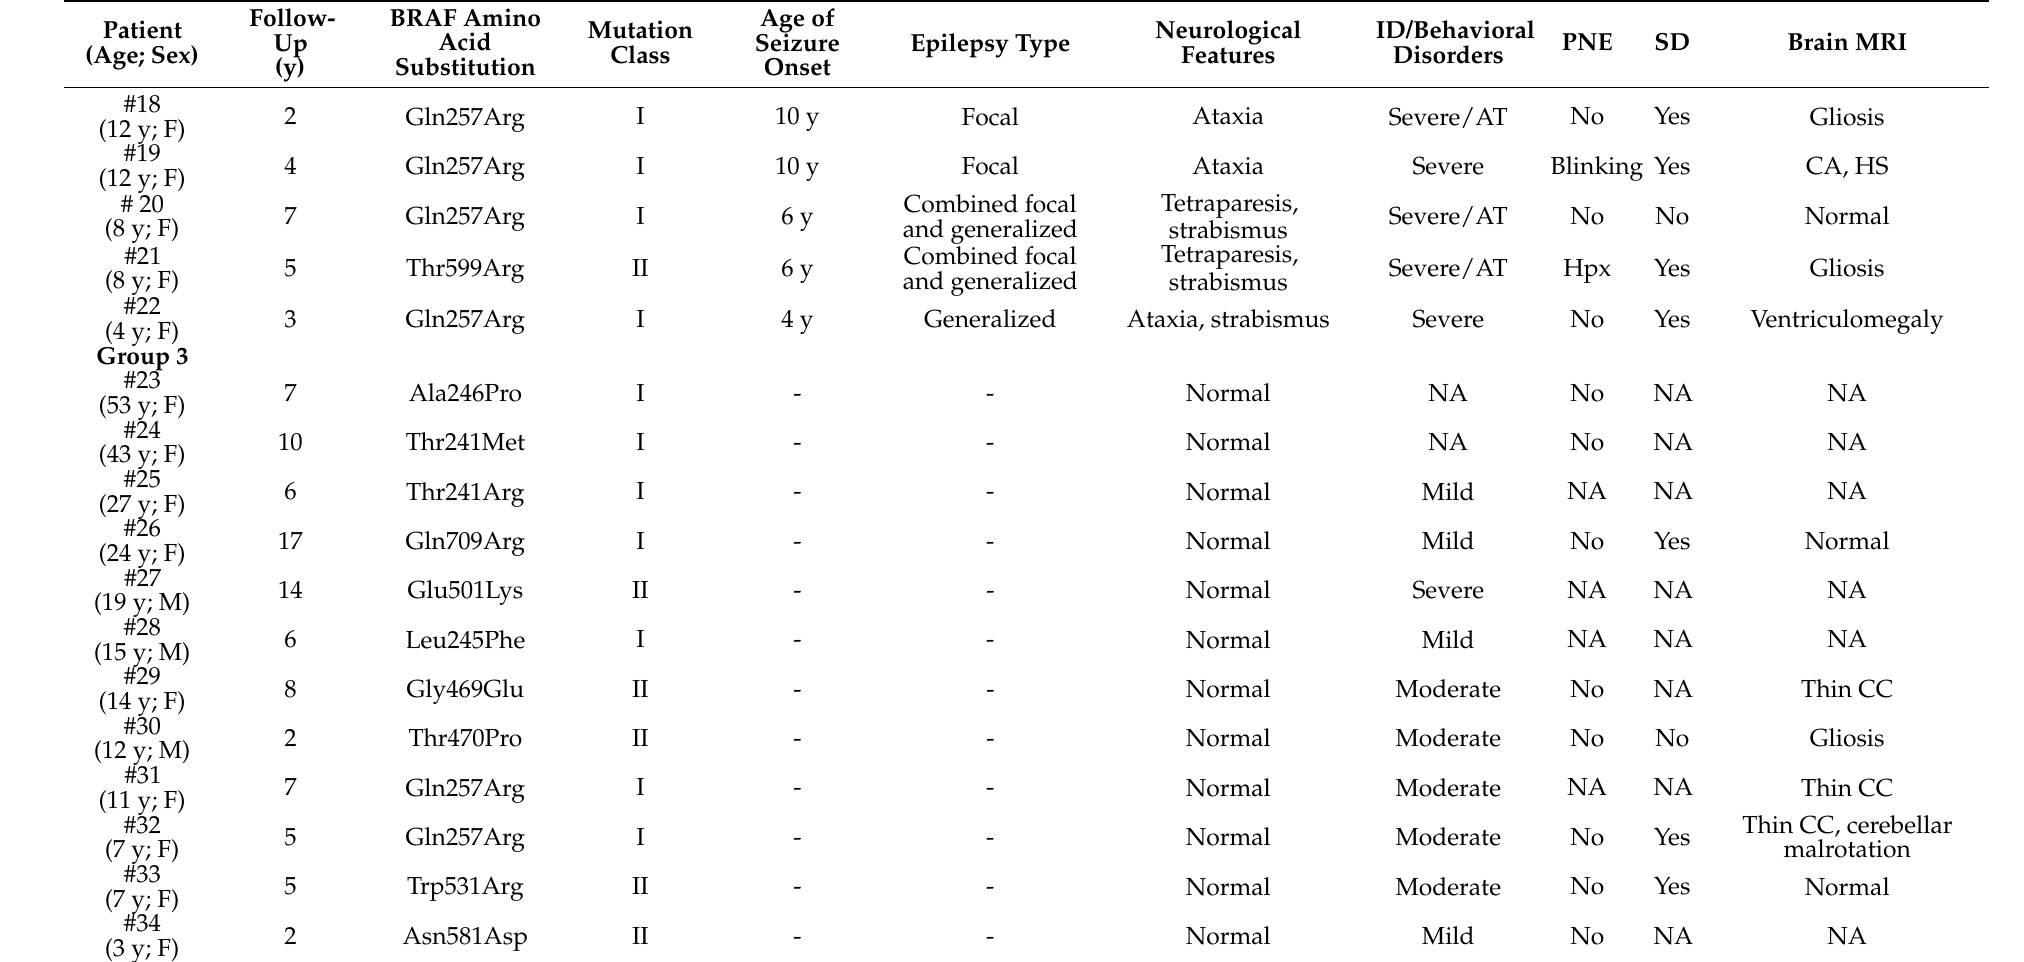
- Normal Mild No NA